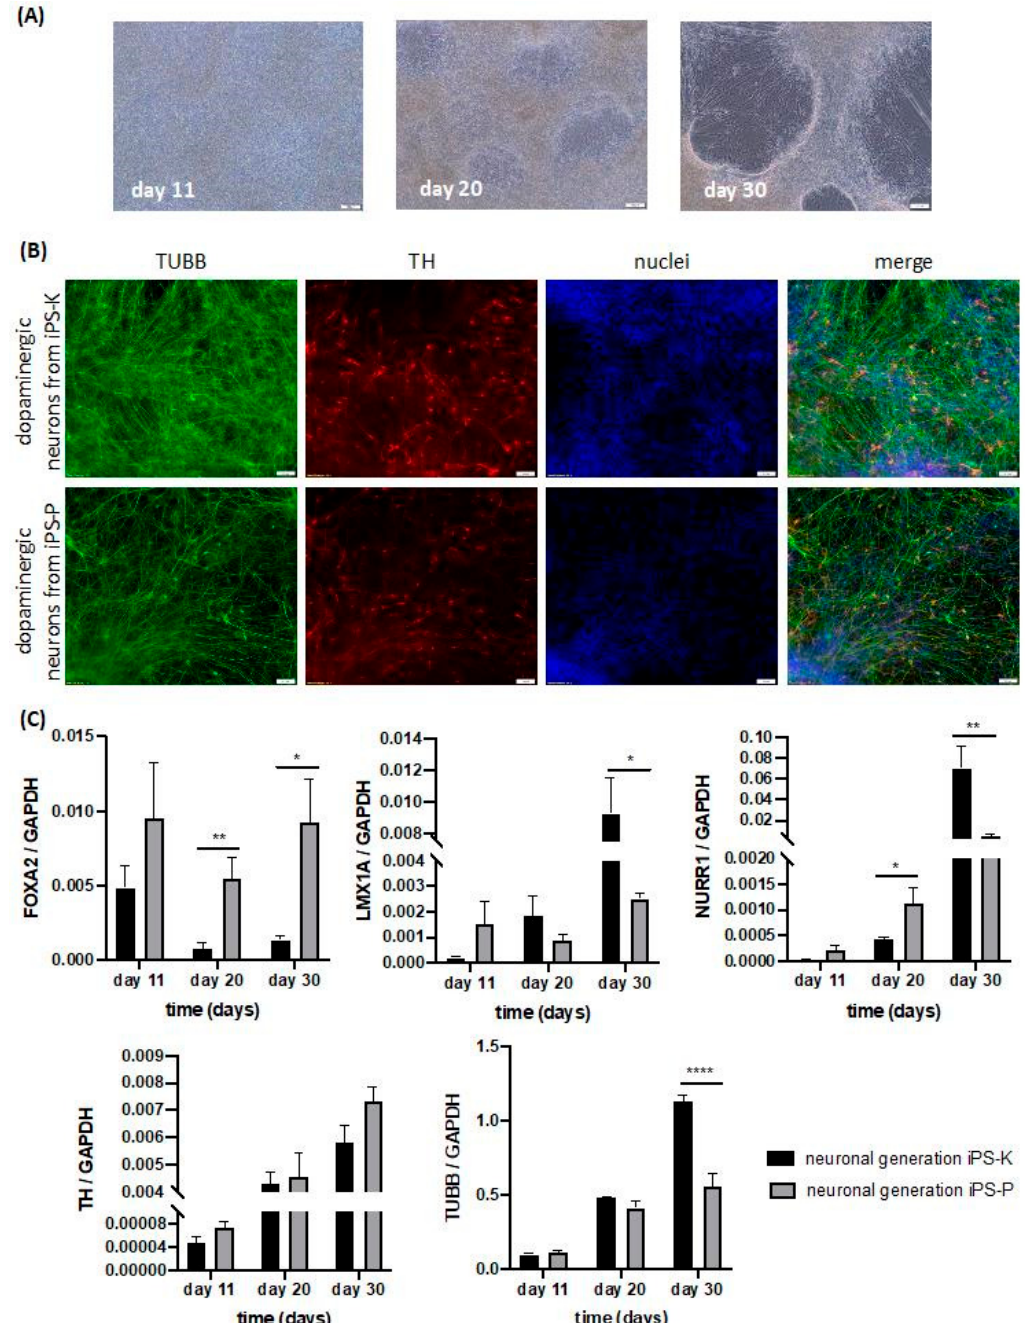
Figure 7. Di ff erences in neuronal cell marker expression levels in dopaminergic neurons generated from iPS cells of di ff erent origin. ( A ) Representative images of morphology of 2D neural di ff erentiation. White scale bars represent 100 µ m. ( B ) Immunofluorescent staining of TUBB and TH in the generated dopaminergic neurons. On day 30, the di ff erentiated cells from iPS-K and iPS-P cells contained TUBB-positive and TH-positive cells. Slightly higher expression of TH was observed in neurons generated from iPS-K cells. Representative images are shown. White scale bars represent 50 µ m. ( C ) Gene expression of neuronal progenitors ( FOXA2, LMX1A ) and neurons markers ( NURR1, TH, TUBB ) in dopaminergic neurons generated from iPS-K and iPS-P in each timepoint (day 11, 20 and 30 of di ff erentiation). Statistically significant higher expression of FOXA2 gene was detected on day 20 and 30 in cells generated from iPS-P cells compared to iPS-K cells, ** p < 0.01, * p < 0.05. Higher expression of LMX1A was observed on day 30 in neurons generated from iPS-K, * p < 0.05. On day 20, statistically significant higher expression of the NURR1 gene was observed in cells from iPS-P cells,